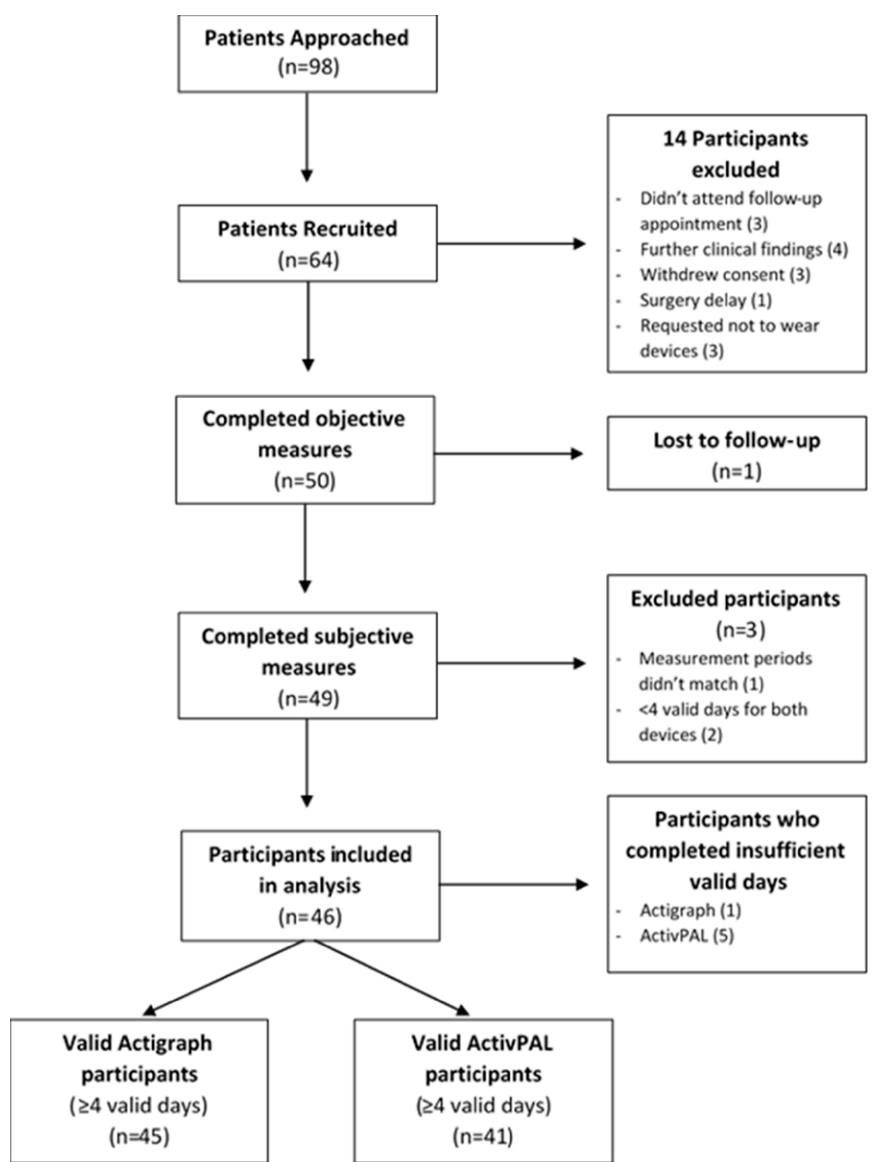
Figure 1. Patient recruitment